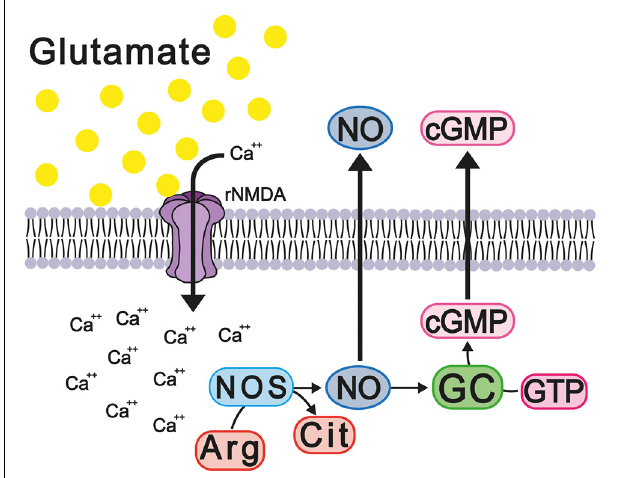
FIGURE 6 | Hyperammonemia causes deregulation of the glutamate-NO-cGMP cycle. These changes increase the release of proinflammatory factors and neuroinflammation with memory